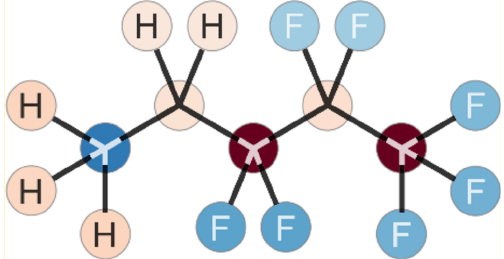
Figure 2. Illustration of the different atom types for parametrization. Four new atom types have been introduced: carbon atoms in a CF 3 group (dark red circle on the right side), carbon atoms in a CF 2 group (beige-colored circle on the right side), and respectively for each group, separate types of fluorine atoms (light blue and blue circles on the right